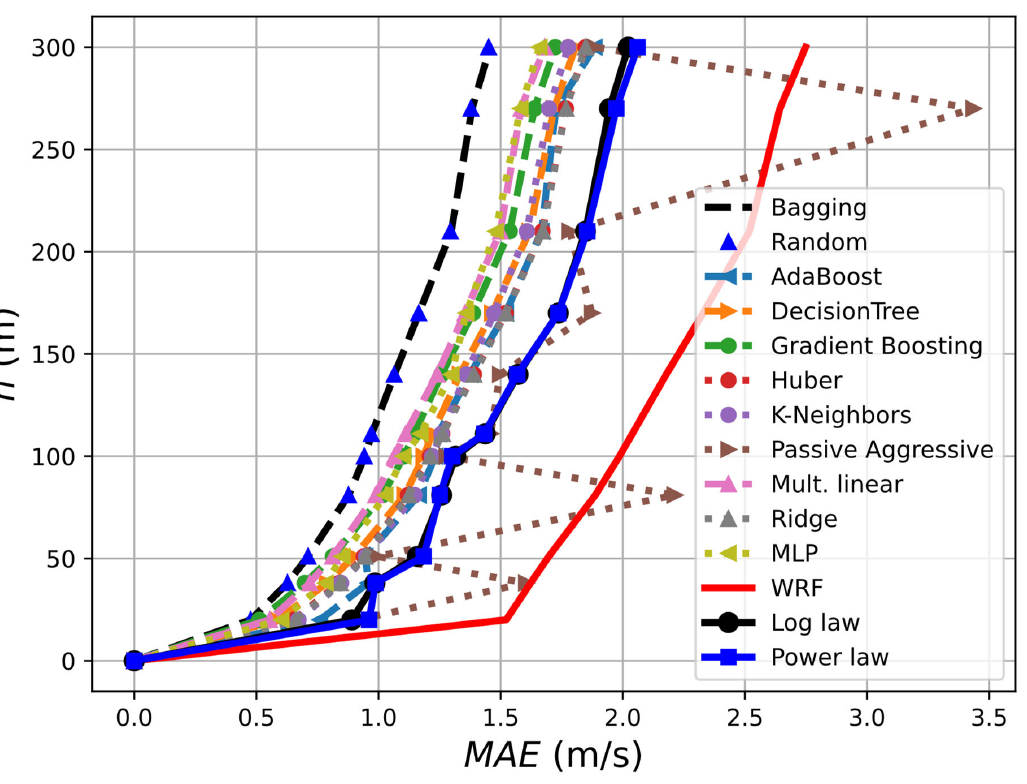
Figure 3. MAE error for different machine learning algorithms using 10 min averaged LiDAR measurements as reference and training data. The results obtained using only the mesoscale model are depicted by the “WRF” line.